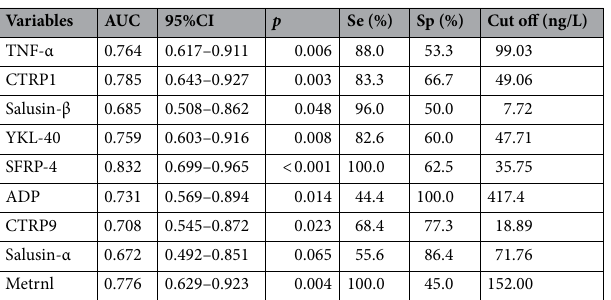
Table 3. The ROC curve analysis of serum inflammatory cytoadipokines for CAD. CTRP, complement-Clq TNF-related protein; YKL-40, Chitinase-3-like protein 1; SFRP4, secreted frizzled-related protein 4; ADP, adiponectin; Metrnl,